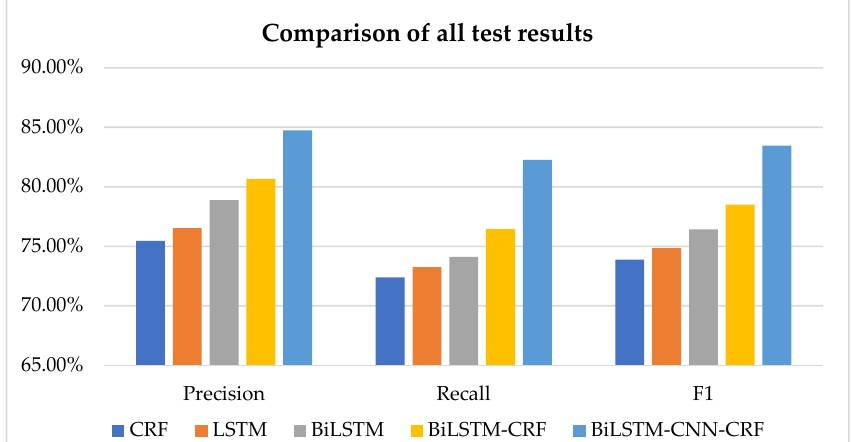
Figure 12. Histogram of comparative analysis of all experience results in this paper.